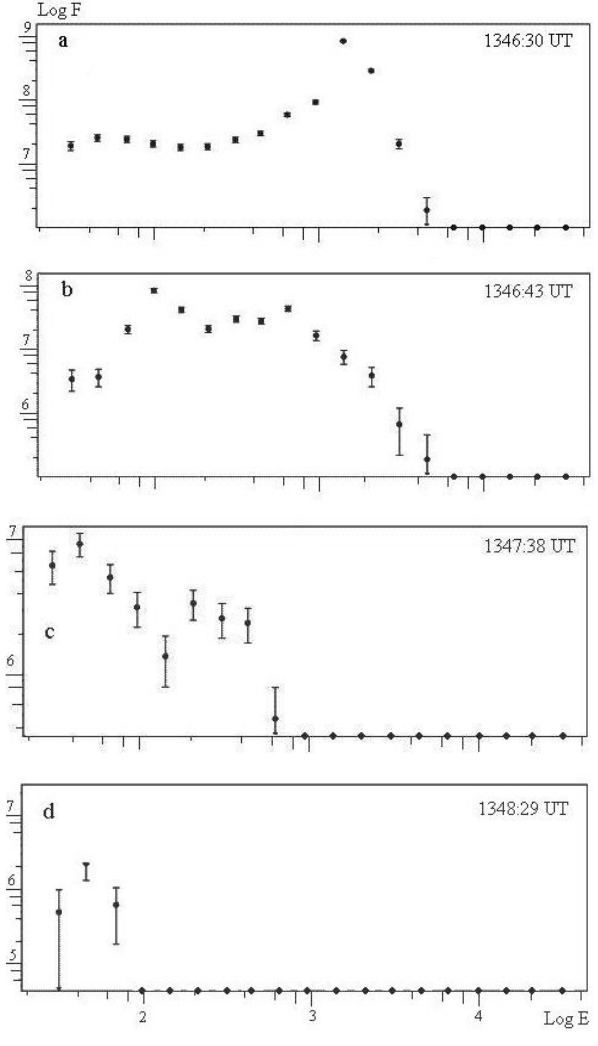
Figure 37. Electron spectra according to DMSP F9 observa- tions on 4 December 1989 at 13:46:30UT (a) , 13:46:43UT (b) , 13:47:38UT (c) , and 13:48:29UT (d) (Zverev et al.,